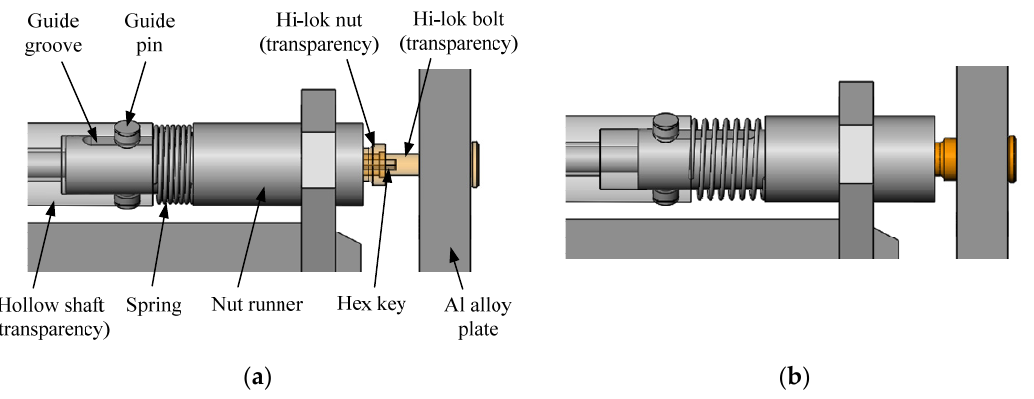
Figure 3. Fastening states, ( a ) Initial state ( b ) Final state.